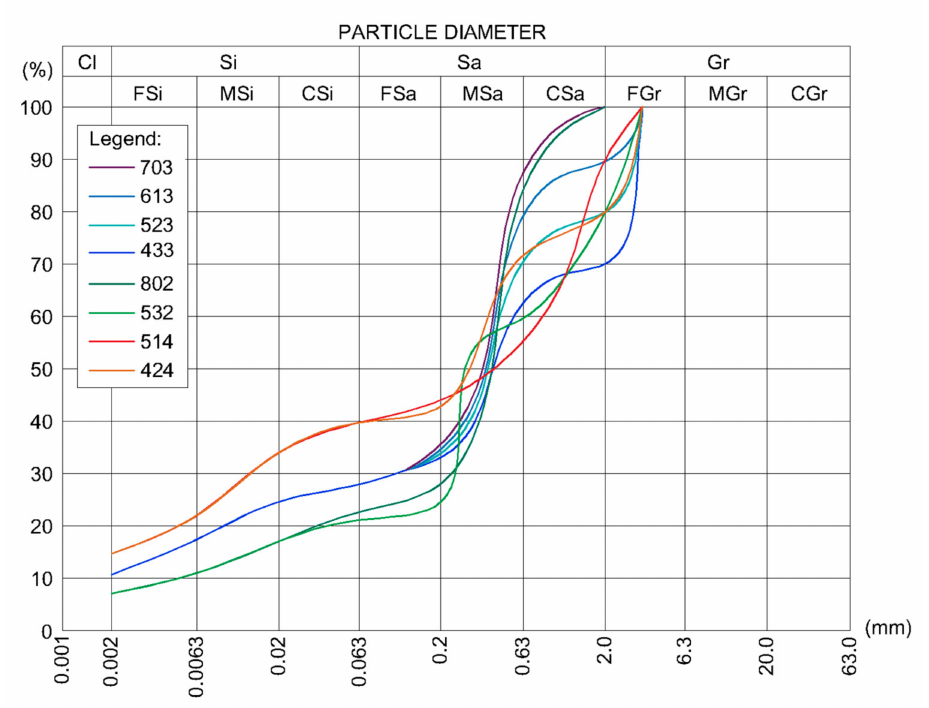
Figure 1. Particle size distribution of soil mixtures used for sample preparation.